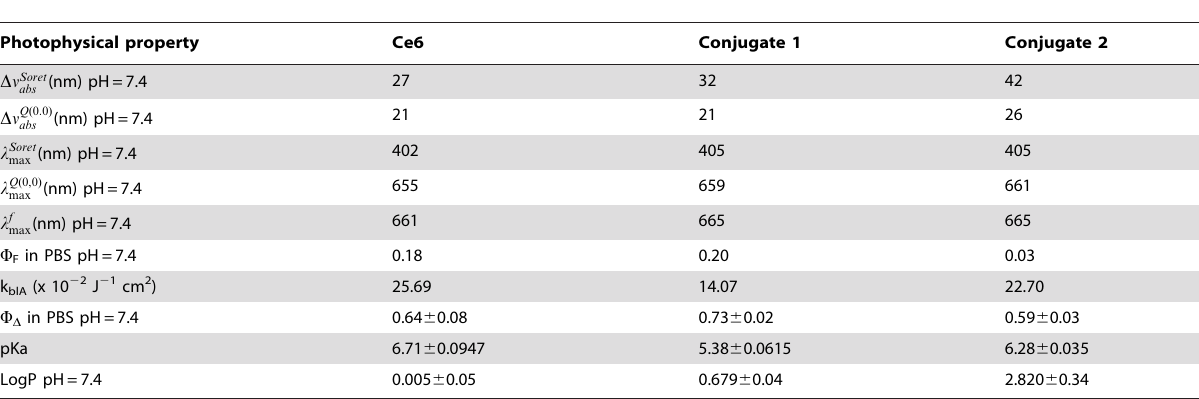
Table 1. Photophysical properties of Ce6, conjugate 1 and 2 in